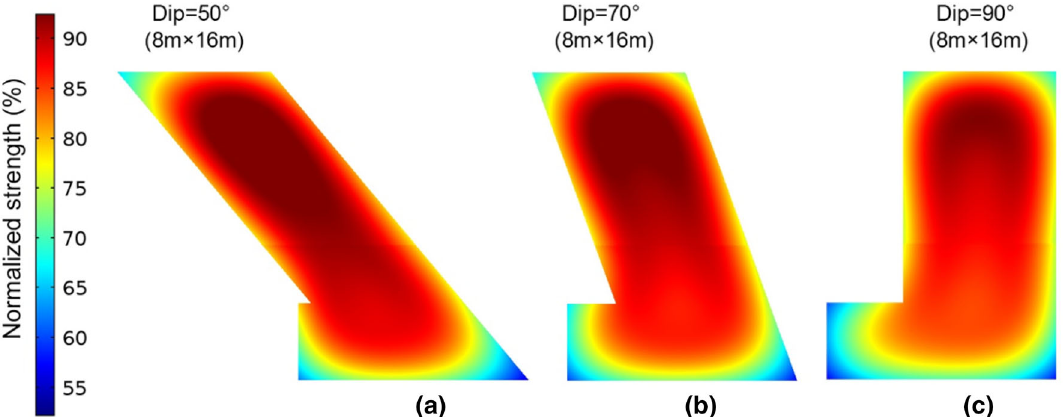
Fig. 19 Effect of inclination angle on spatial distribution of strength of CPB with curing time of 28-days: a 50 (cid:3) , b 70 (cid:3) , and c 90 (cid:3) .